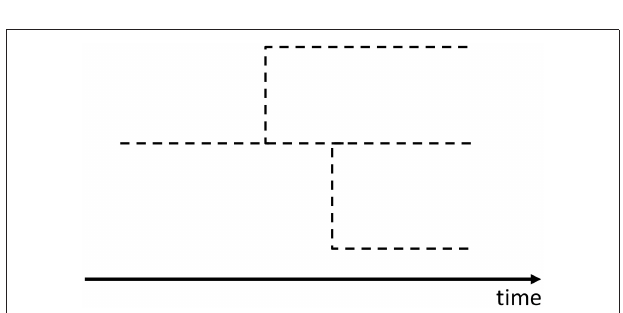
FIGURE 2 | An example of the evolutionary tree of species in the Yule process.